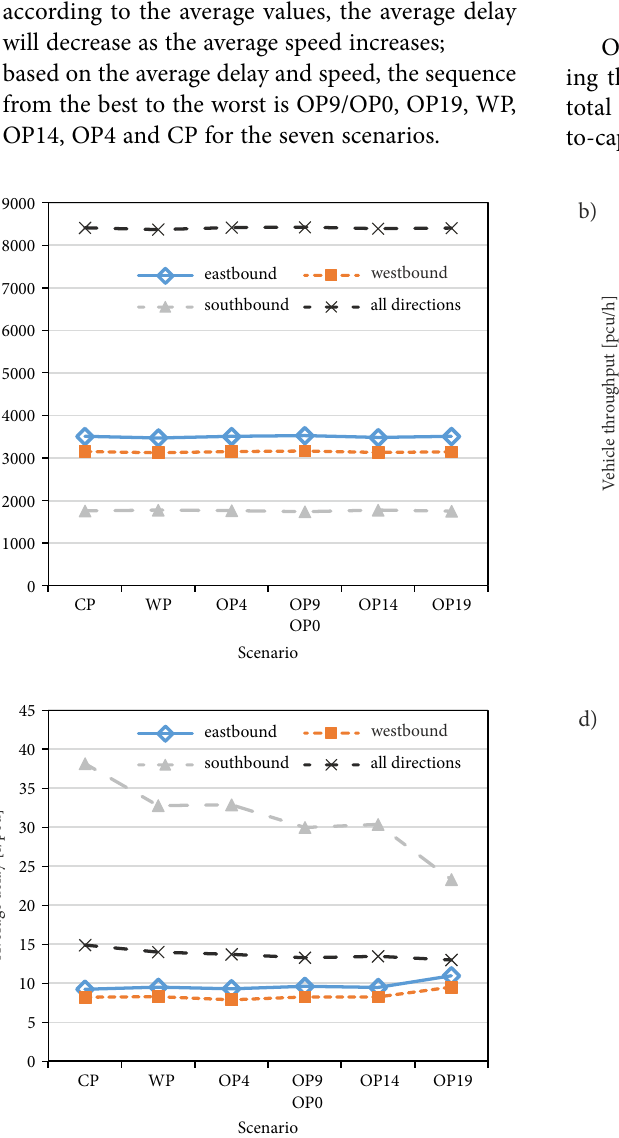
Figure 7. Comparison of vehicle throughputs and average delays under different scenarios: a – vehicle throughputs for intersection A; b – vehicle throughputs for intersection B; c – average delays for intersection A; d – average delays for intersection